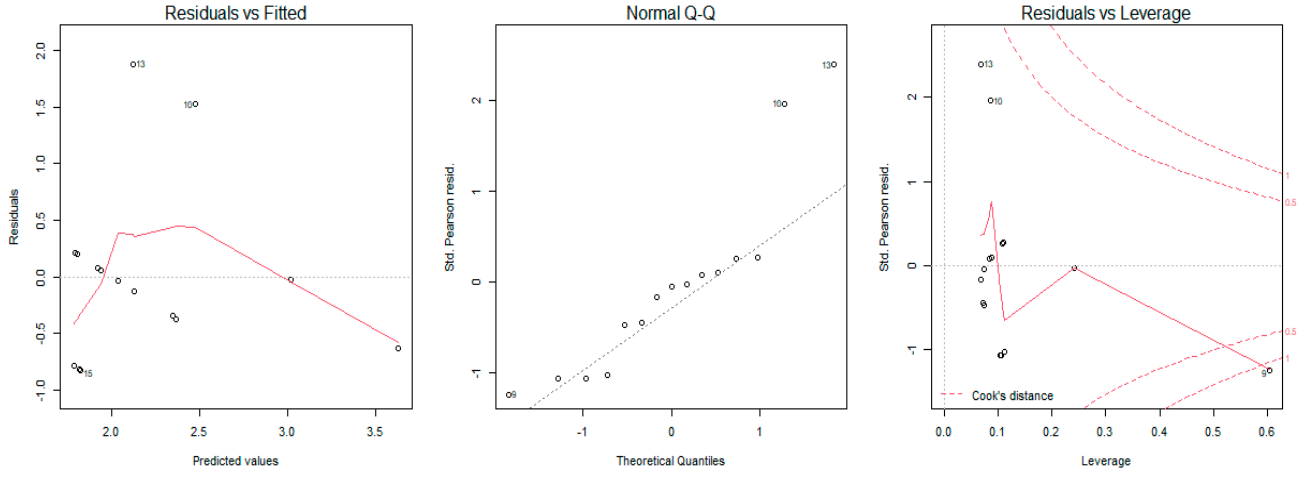
Figure 3. Graphical analysis of residuals for the MRC and sEMG model for Triceps Brachii muscle. The plot on the left shows the residual errors versus their estimated values; the QQ-plot in the center shows the distributive normality of the residuals; the plot on the right identifies any influential data points on the model.